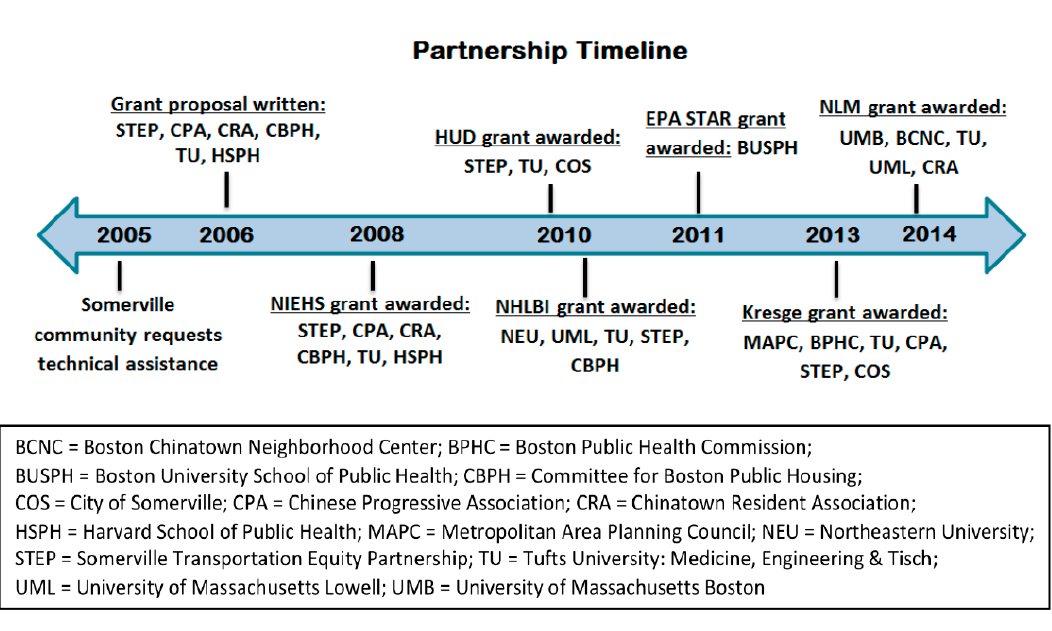
Figure 1. The Community Assessment of Freeway Exposure and Health (CAFEH) Partnership Timeline.